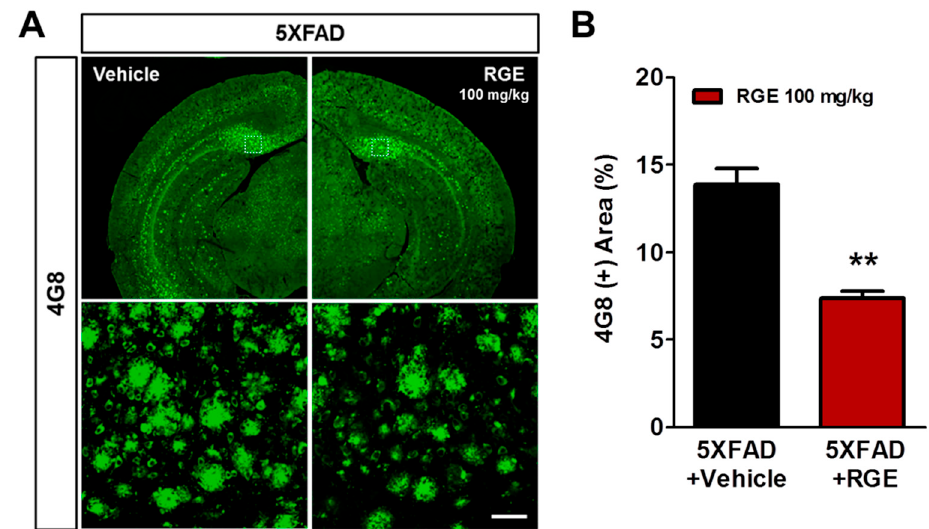
Figure 3. Effects of RGE on A β accumulation in the subiculum of 5XFAD mice. ( A ) Immunohistochemical analysis of A β burden was performed with the 4G8 antibody in the subiculum of 5XFAD mice (scale bar = 100 μ m). ( B ) 4G8 (+) areas were significantly reduced in the subiculum in RGE-treated 5XFAD mice compared with those in vehicle-treated 5XFAD mice. Data are presented as mean ± SEM. ** p <